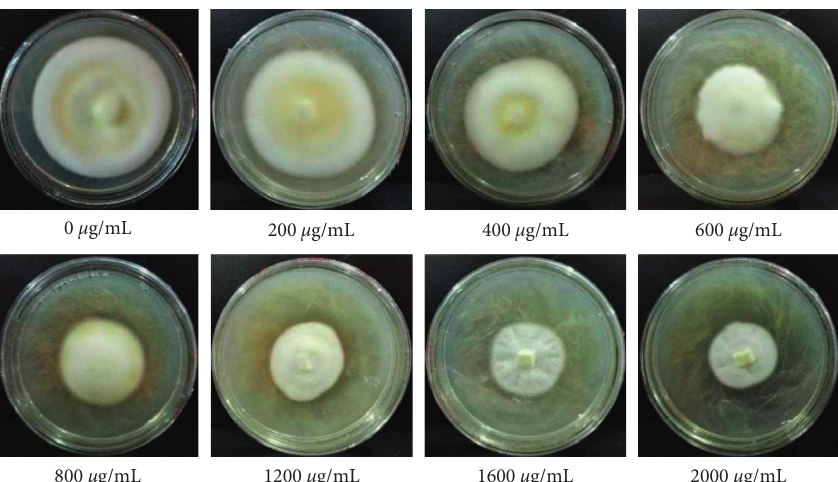
Figure 1: Inhibition of different concentrations of hygromycin on the growth of C. militaris . (a) 0 μ g/mL. (b) 200 μ g/mL. (c) 400 μ g/mL. (d) 600 μ g/mL. (e) 800 μ g/mL. (f) 1200 μ g/mL. (g) 1600 μ g/mL. (h) 2000 μ g/mL.